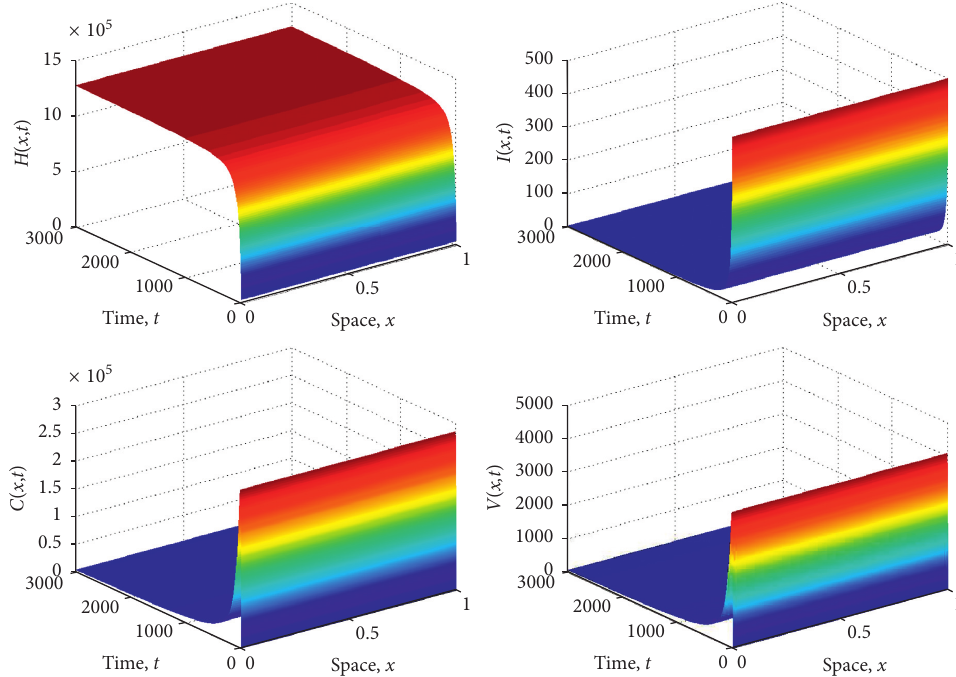
Figure 1: Stability of the infection-free steady state P